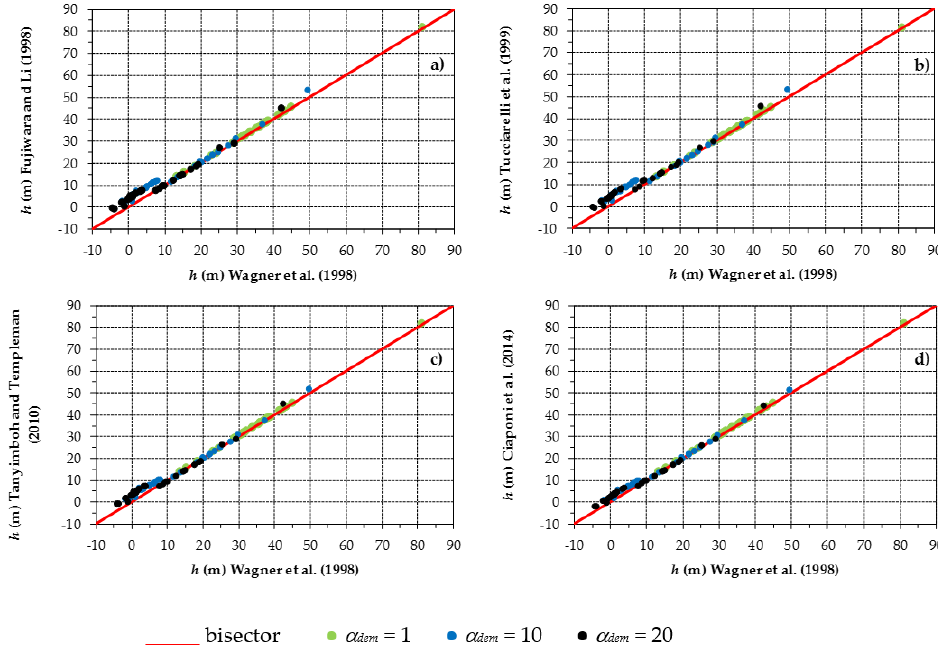
Figure 6. First case study. Comparison of the various formulations, ( a ) Fujiwara and Li [12], ( b ) Tucciarelli et al. [13], ( c ) Tanyimboh and Templeman [17] and ( d ) Ciaponi et al. [20], in terms of nodal pressure head h